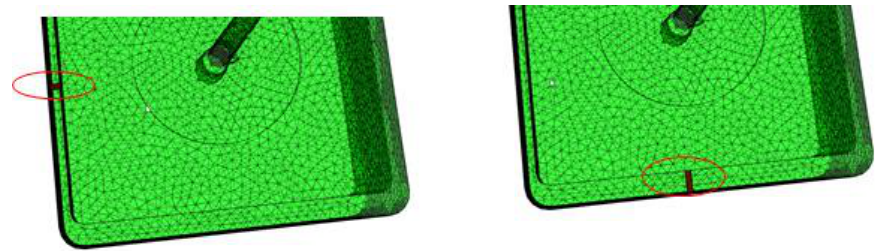
Figure 8. Positions of the element stacks to evaluate fiber orientation.